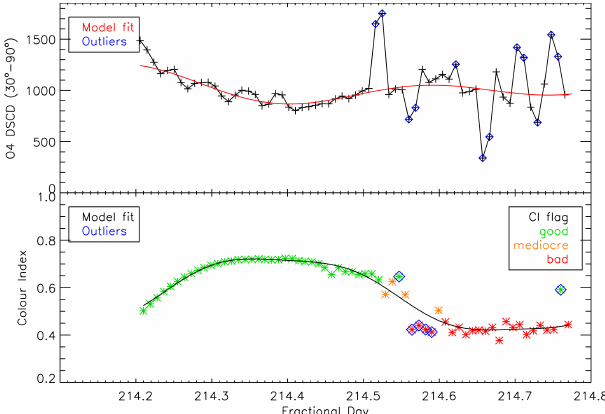
Figure 9. Top panel: results of the O 4 DSCD modelling (green line) to the measured O 4 values (black crosses) and outlier detection (blue diamonds) for the multiple-scattering flagging, for an exam- ple day in Brussels. For comparison we also show the results of the CI flagging (bottom panel). The CI values (asterisks) are coloured according to their CI flag. Outliers from the broken-cloud flagging are marked with a blue